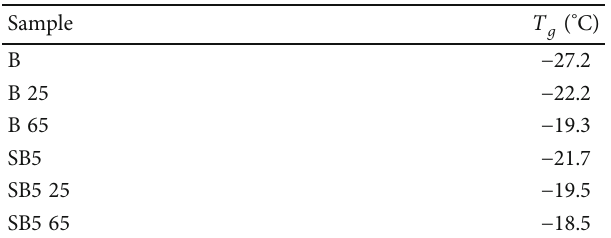
= 0 ° C and ω = 10rad s − 1 test r Table 1: Glass transition temperatures from the simulated temperature sweep tests.